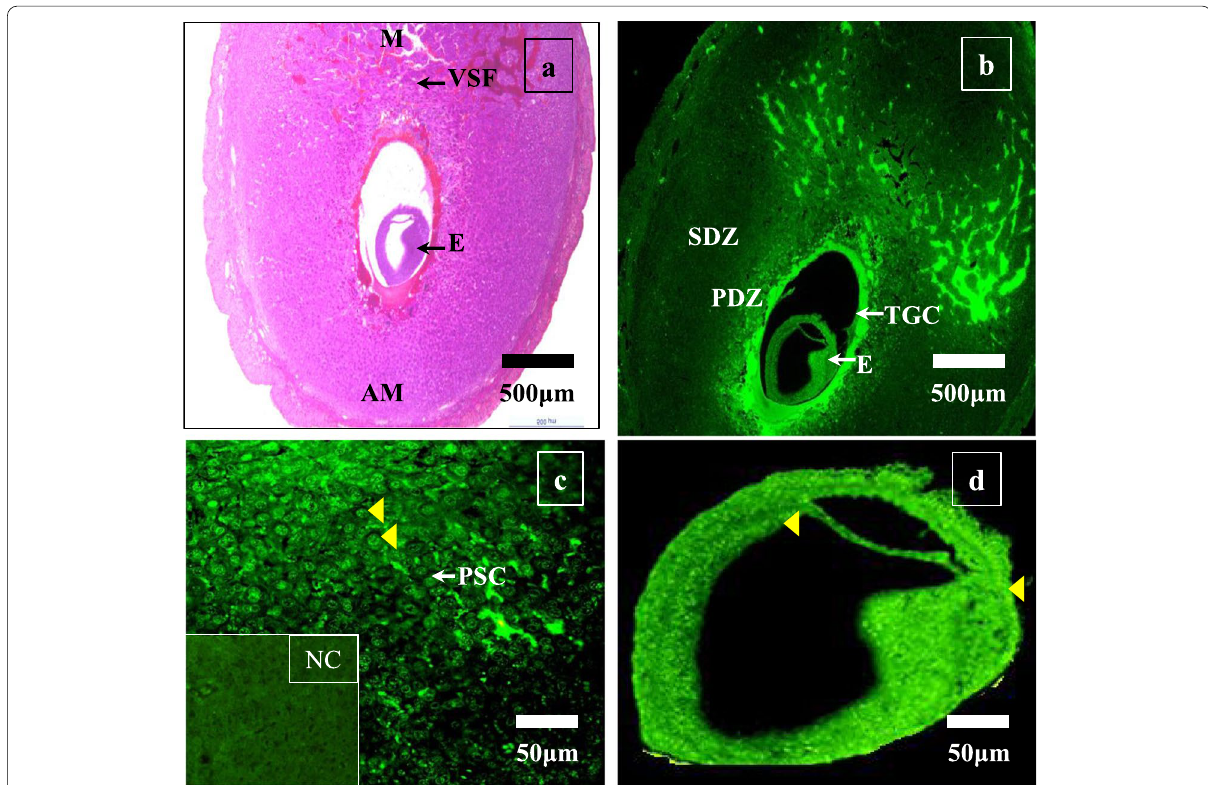
Fig. 7 Immunofluorescence of KLF5 on D8 mice uterus using FITC-conjugated antibody. The protein was localized in the proliferating stromal cell (PSC) and embryo (E). The arrowhead indicates the expression. Original magnification: a 5 antimesometrial pole; PDZ, primary decidual zone; SDZ, secondary decidual zone; TGC, trophoblast giant cell; YC, yolk cavity; NC, negative